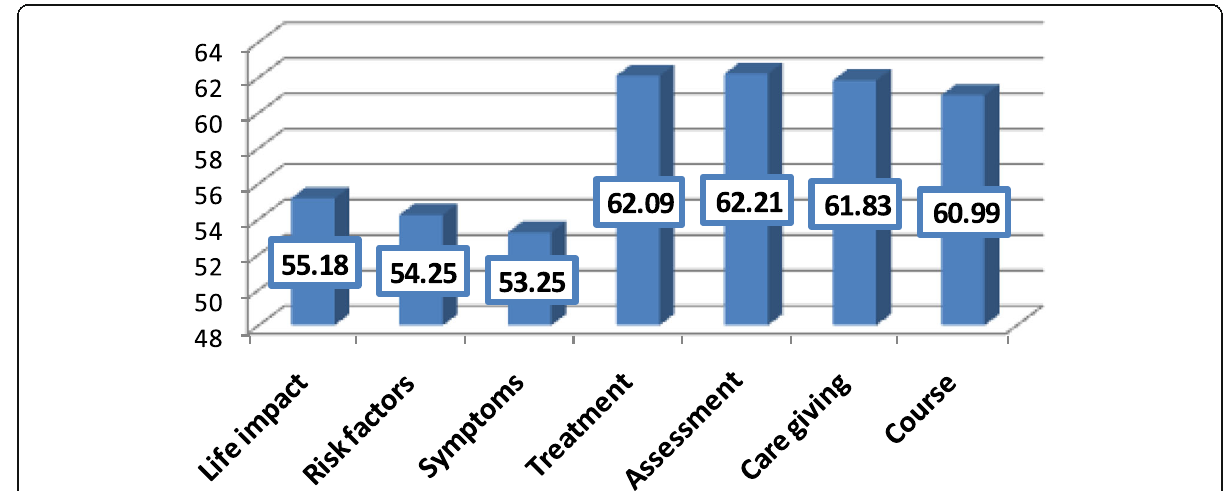
Fig. 4 Mean percentage of knowledge of different subscales of Alzheimer ’ s